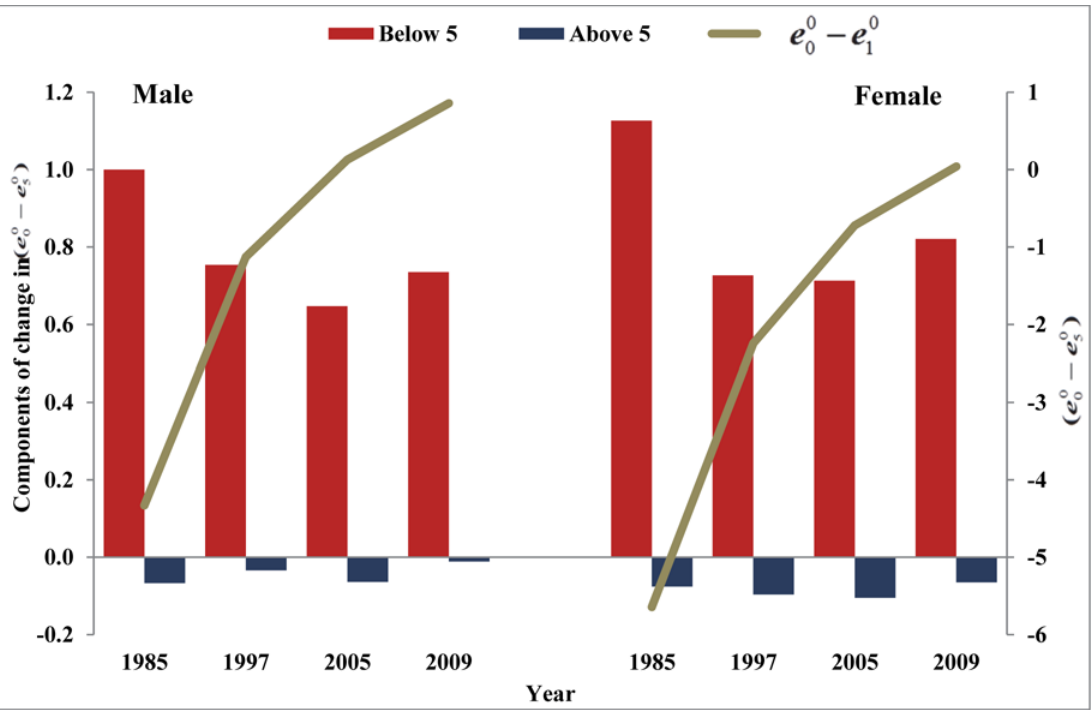
Fig 5. Gap in life expectancies at ages zero and five and the components of the change in the gap over time, India, 1981 – 2009.